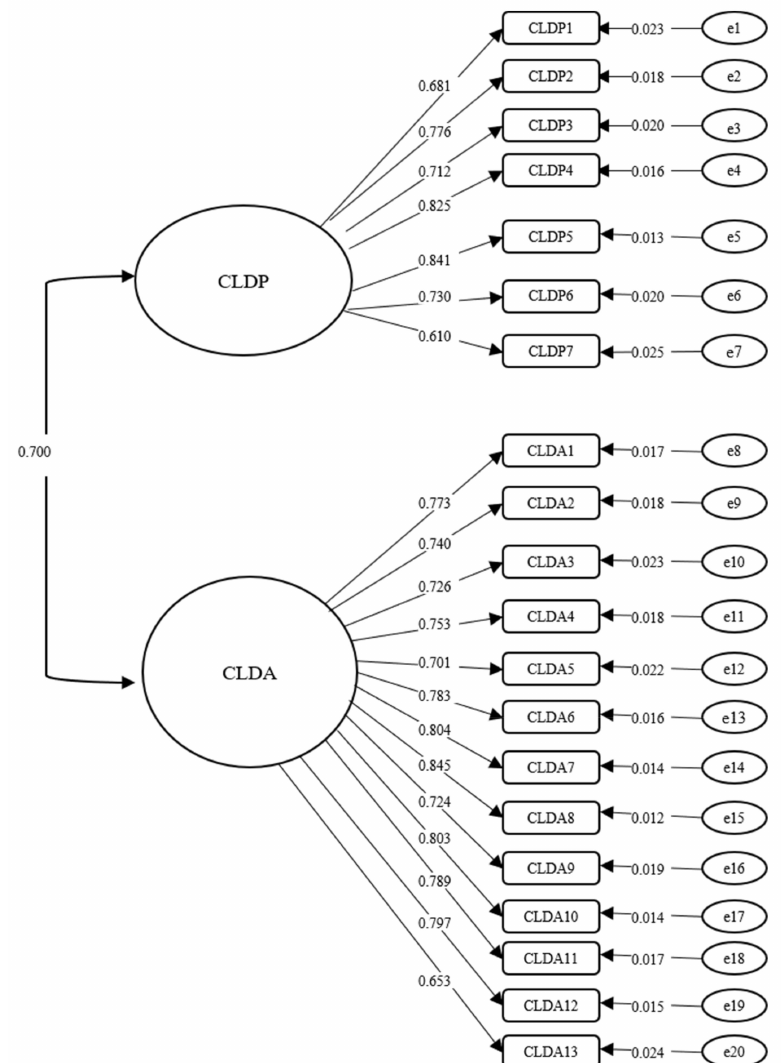
Figure 1. CFA factor structure and the standardized factor loadings ( n = 1018). CLDP = career and life development pathways; CLDA = career and life development agency. All coefficients shown in this figure are factor loadings that are statistically significant at the p < 0.001